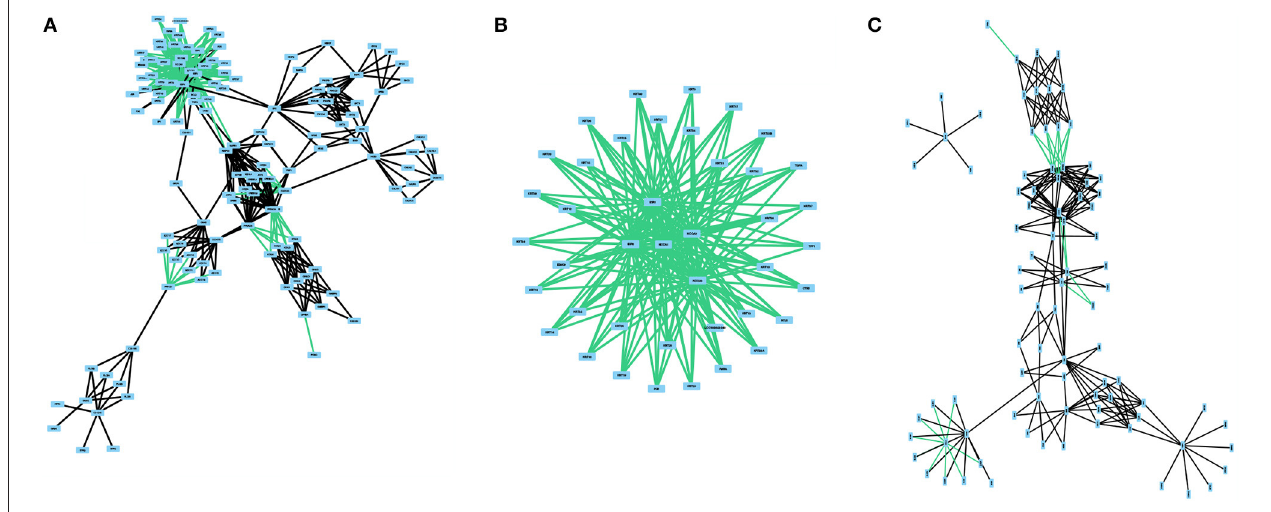
FIGURE 3 | The different subnetworks related to estrogen signaling, regulation and protein interactions. All networks were obtained from KEGG. (A) presents the integrated network with all three network classes. (B) represents the regulatory network. (C) depicts the protein-protein interaction network. No catalytic reactions are present in the KEGG